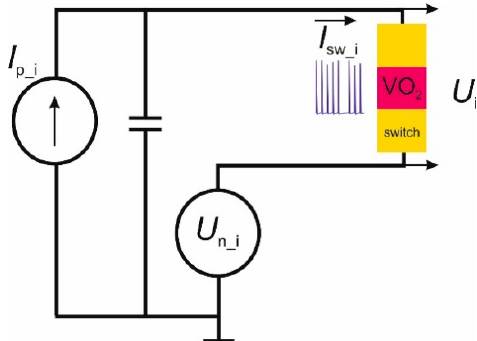
Figure A1. Circuit of a single oscillator of a VO 2 -based structure. I is the number of an oscillator; I p_i is a source of current, C is a capacitance, U n_i is a source of noise, I sw_i is the current through the VO 2 switch, U i is the voltage at the switch.